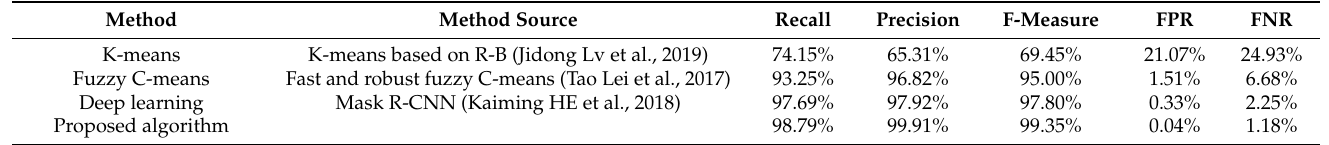
Table 1. Performance of different methods in terms of the average values of the metrics.